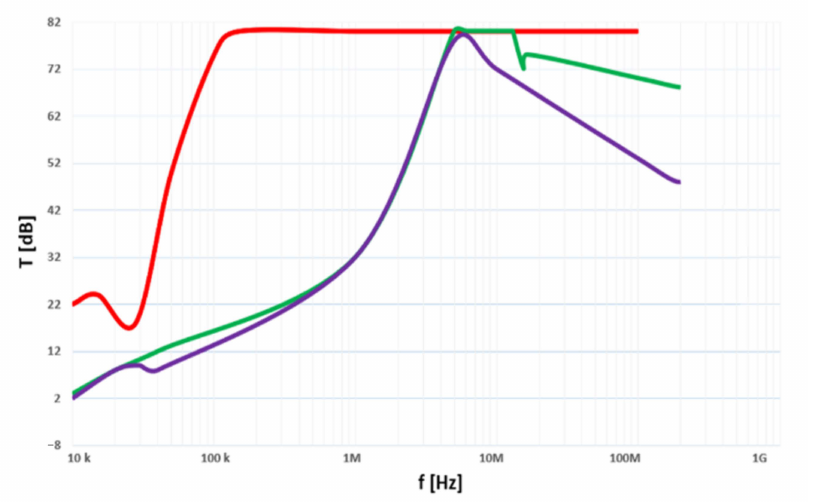
Figure 6. Insertion loss of the main filters: FN 700Z-20-03 (red), FN 686-25-23 (green), and FN 2070-3-06 (purple) according to CISPR